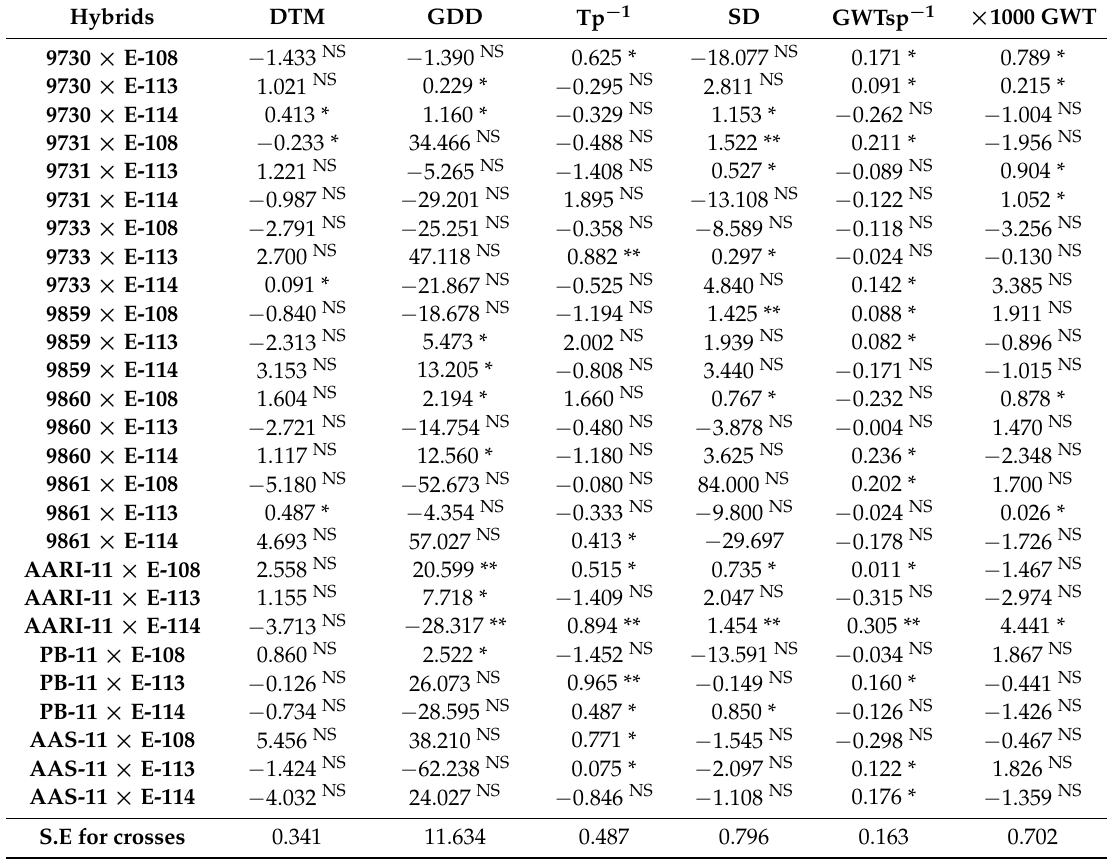
Table 3. Specific combining ability (SCA) effects of F 1